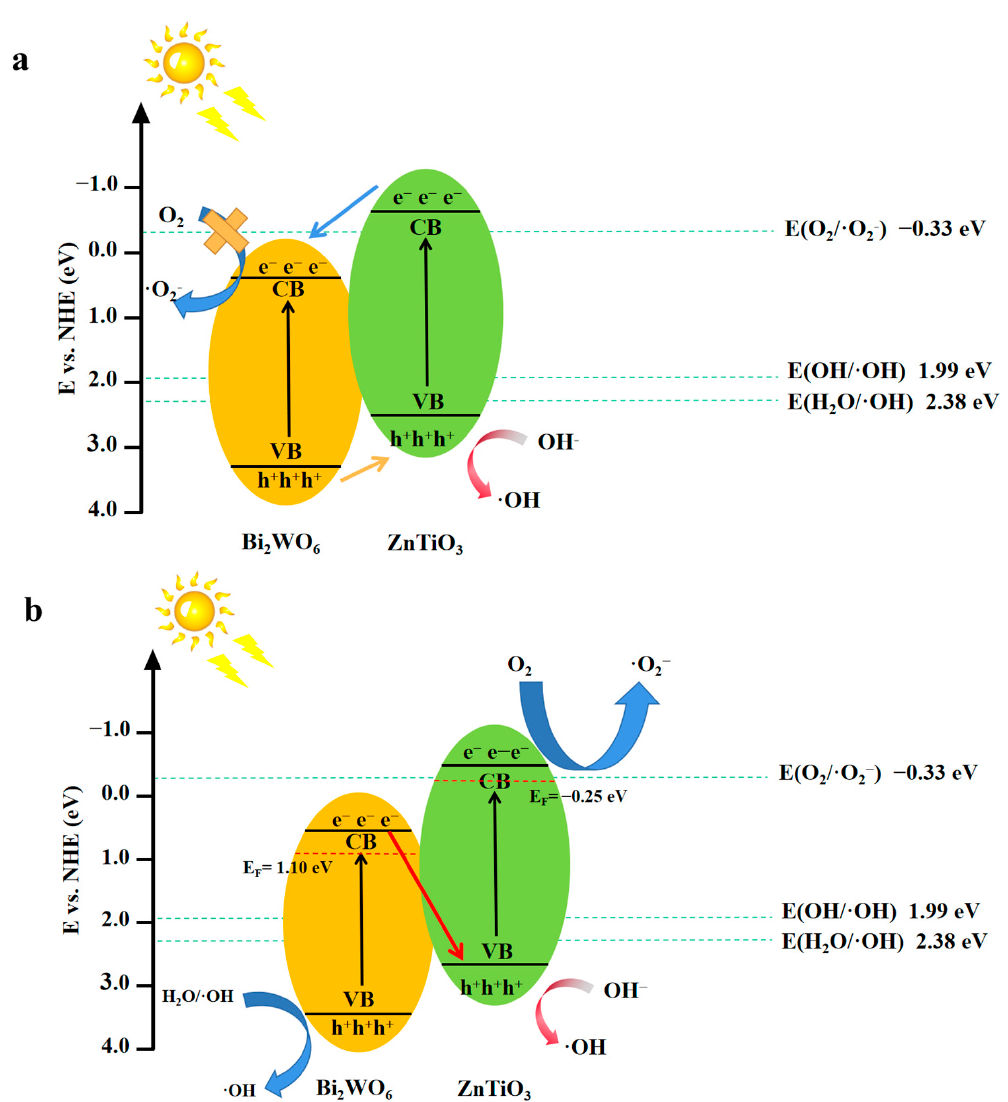
Figure 11. ( a ) P-n heterojunction and ( b ) S-scheme heterojunction mechanism of ZnTiO 3 /Bi 2 WO